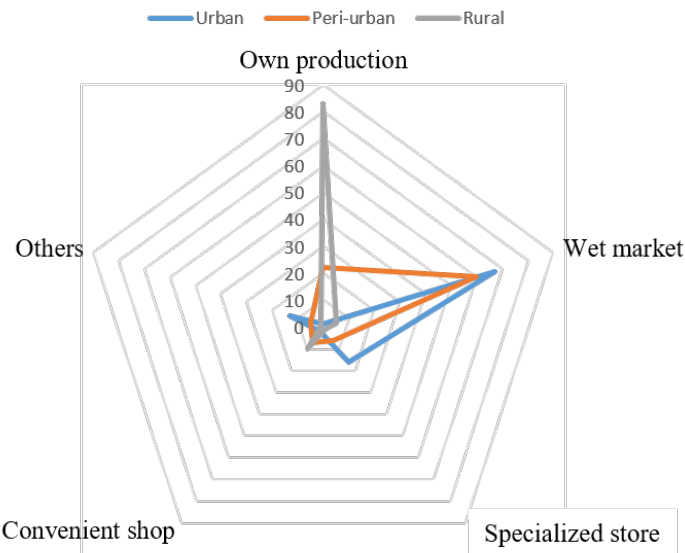
Figure 4. Food sources of household-level diets (%).